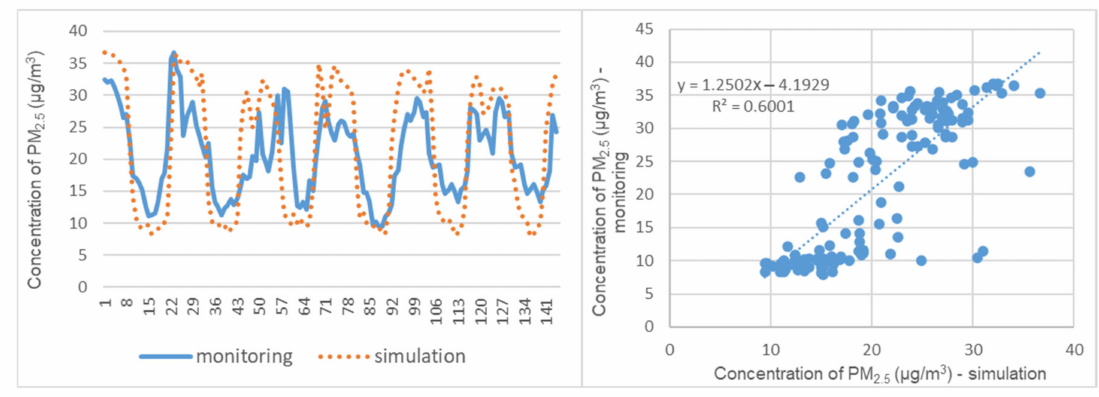
Figure 2. Comparison results of PM 2.5 simulation and monitoring from Nguyen Van Cu station from 12–17 June 2017.